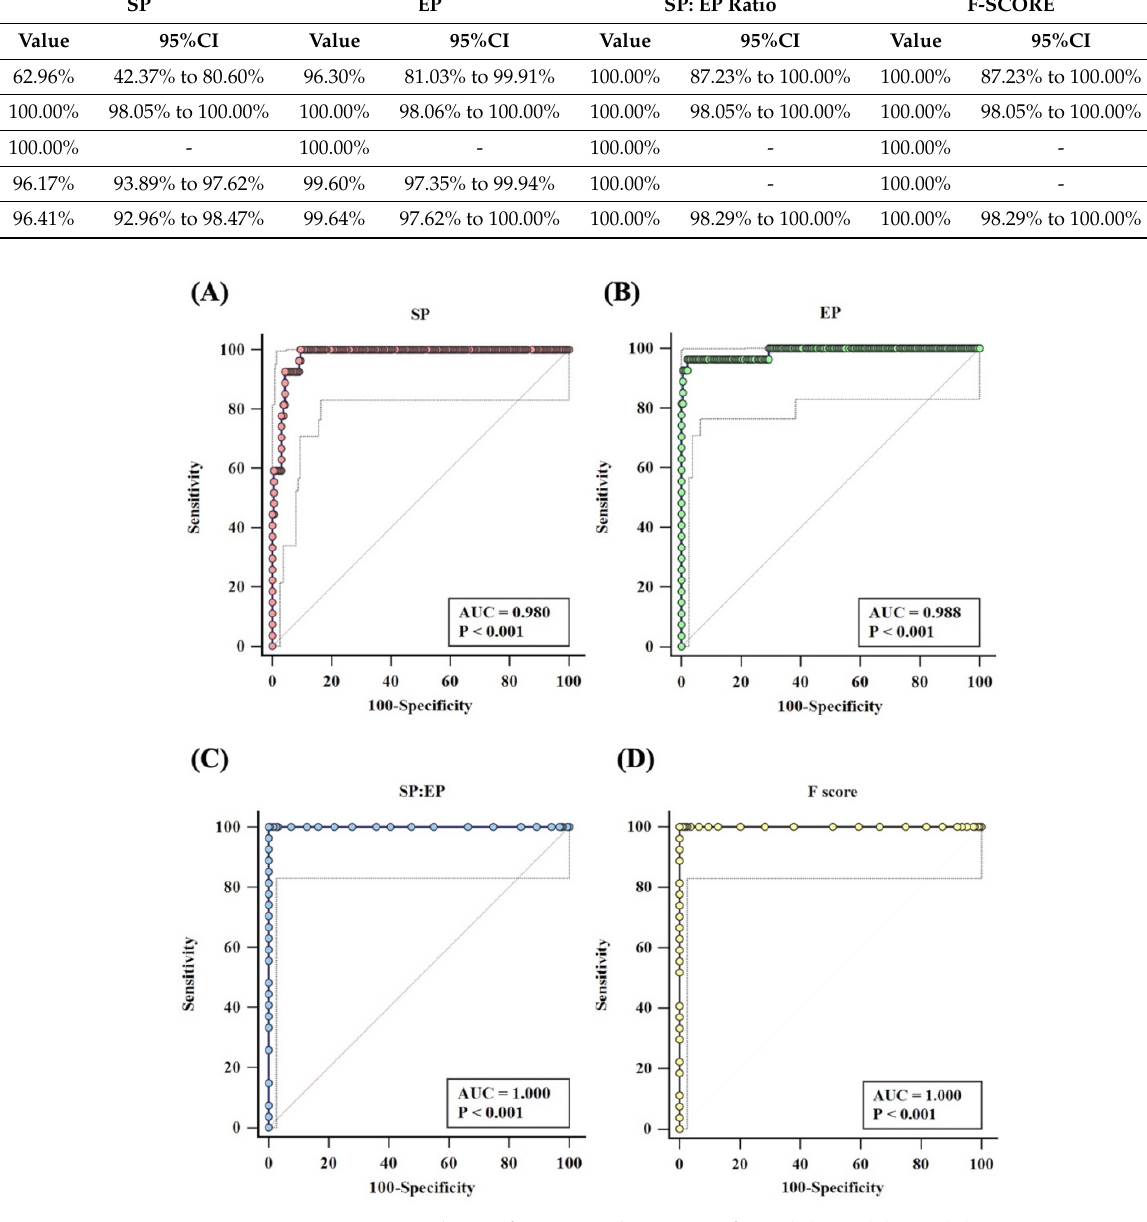
Figure 4. ROC curve analysis of grey pixel intensity from ( A ) SP, ( B ) EP, ( C ) SP: EP ratio, and ( D )